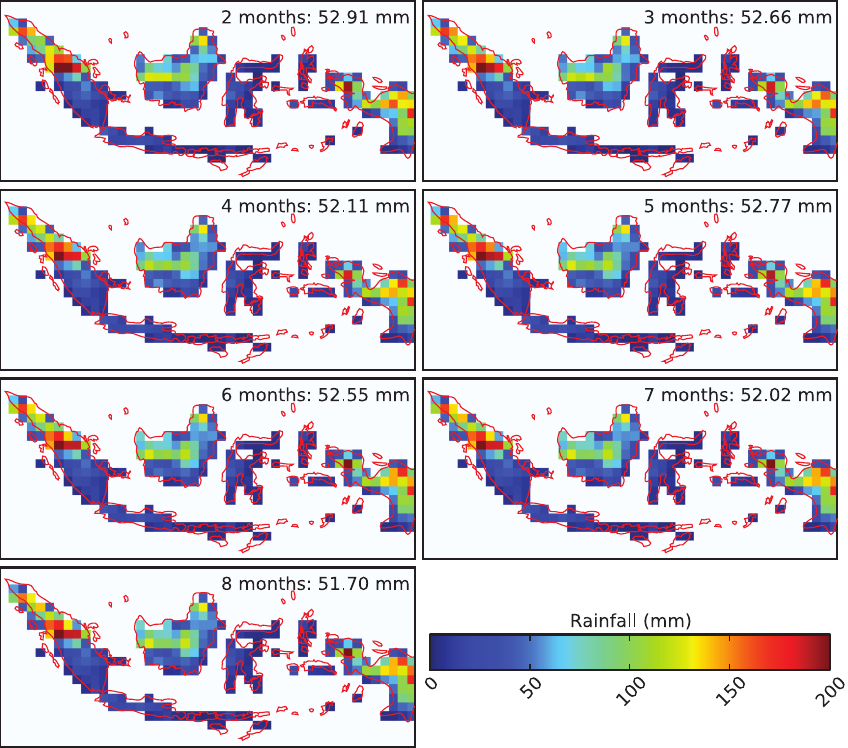
Figure 10. 1997 mean corrected GPCP rainfall rates (per month) during dry season based on using different time frames to convert GPCP to TRMM. The numbers indicate the 1997 mean rainfall for Indonesia during the dry season.